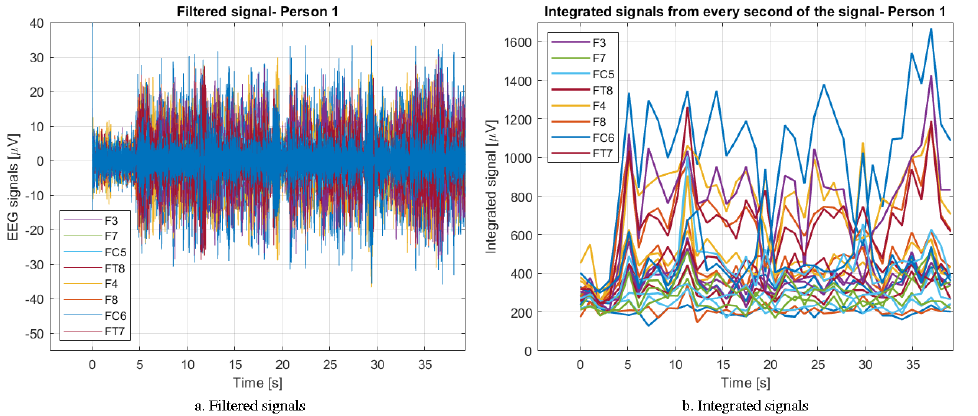
Figure 6. Comparison of filtered and integrated signals—Person 1.